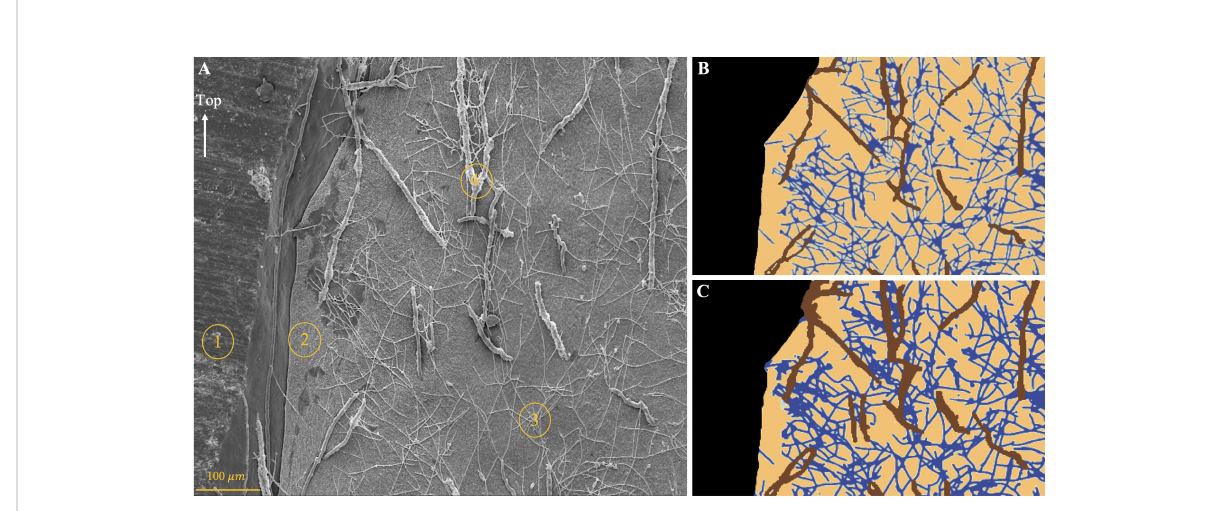
FIGURE 3 Illustration of the manual vs machine learning image analysis. (A) Original SEM image displaying the four classes of items that the Convolutional Neural Network model had to recognize: resin, coral skeleton, thin microborings, and wide microborings. (B) Result of the manual quanti fi cation of the area of coral skeleton colonized by thin (dark blue) and wide microborings (brown), uncolonized coral skeleton (orange), and resin (black). (C) Result of the machine learning